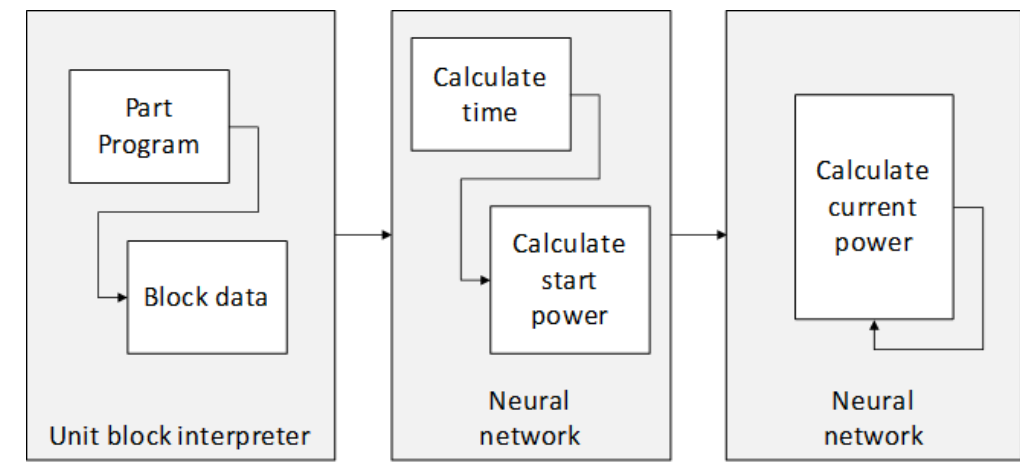
Figure 8. Profile generation